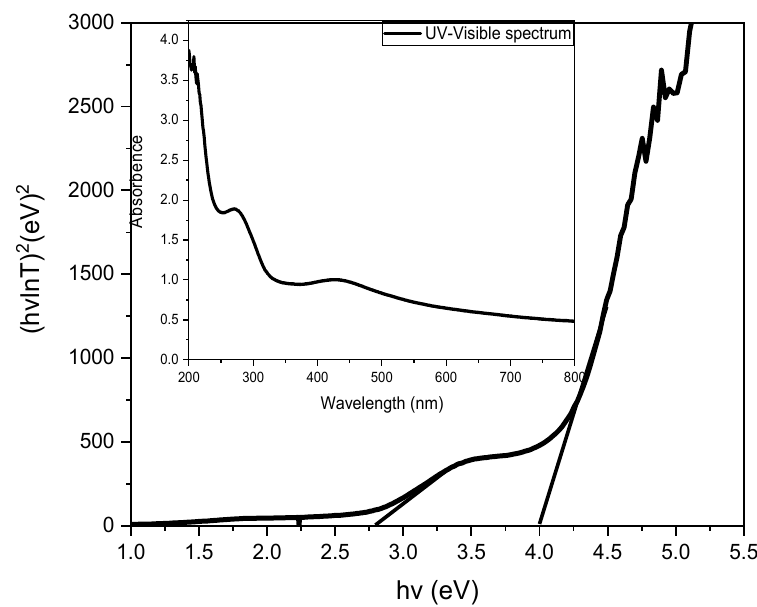
Figure 5. Tauc plot (inset: UV-Visible spectrum) of Ag-CuO NC.